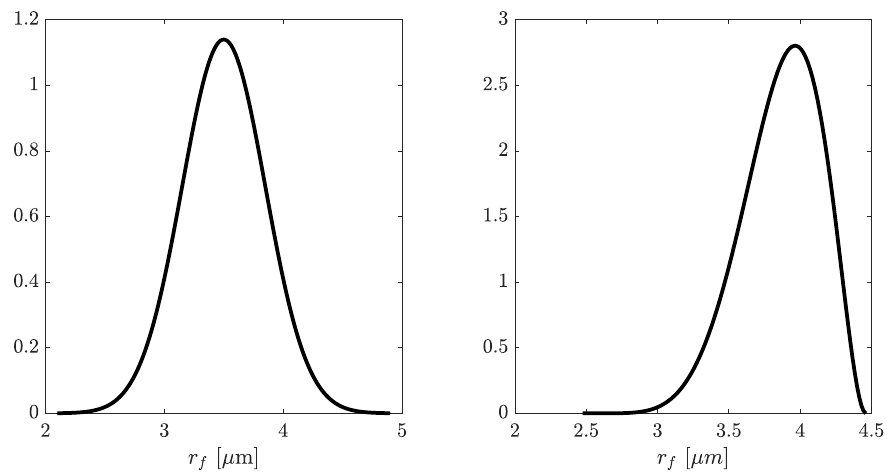
Figure 5. PDF of the random fiber radius for training ( left ) and validation ( right ) of the ANN.